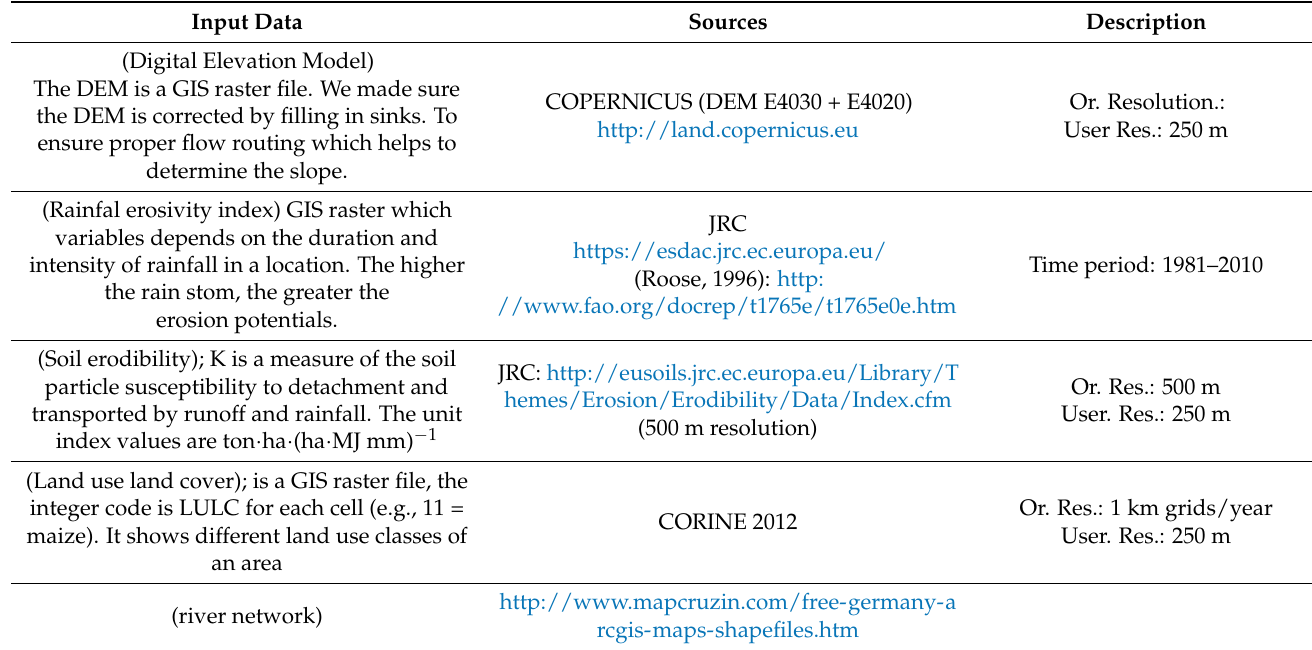
Table A1. Description of InVEST input data, data sources required for the set-up/calibration and their resolutions. Input